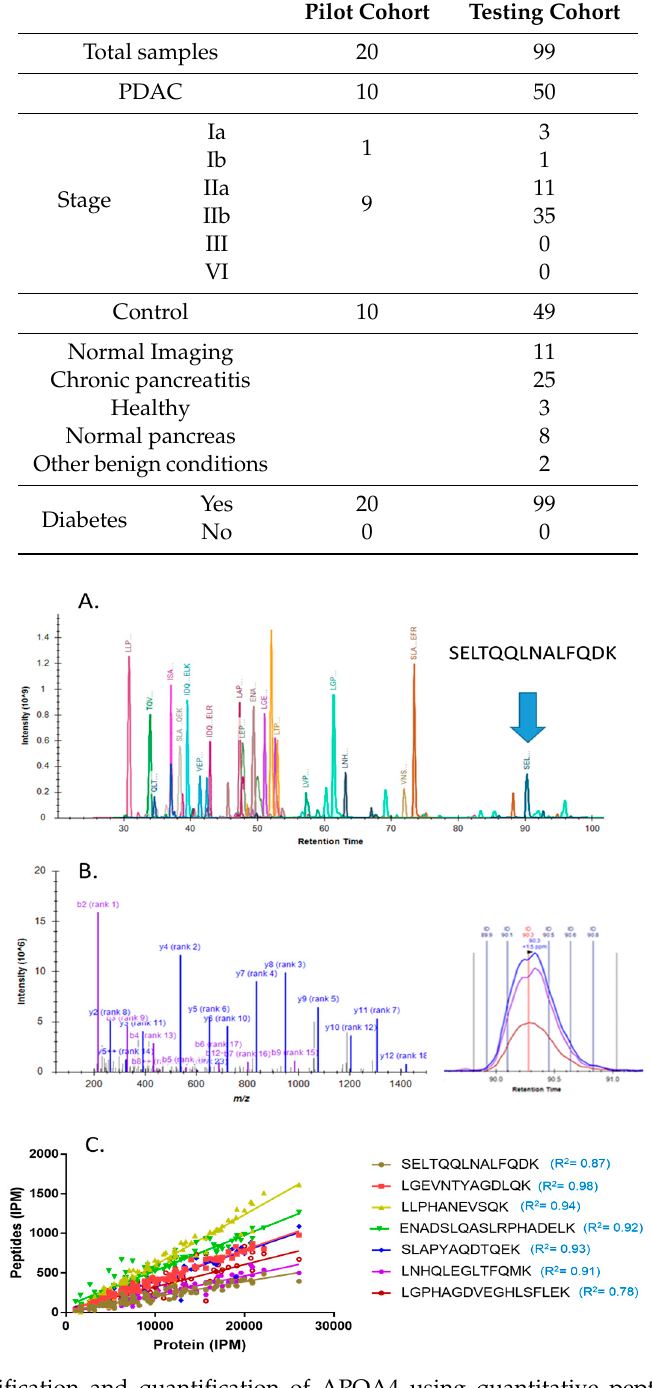
Figure 3. Identification and quantification of APOA4 using quantitative peptides. ( A ) Seven quantifiable peptides eluted at different retention times were selected for APOA4 quantification. The blue arrow indicates the detection of peptide SELTQQLNALFQDK, ( B ) peptide identification and quantification using SELTQQLNALFQDK as an example, ( C ) correlations of APOA4 measurement with the corresponding peptides.